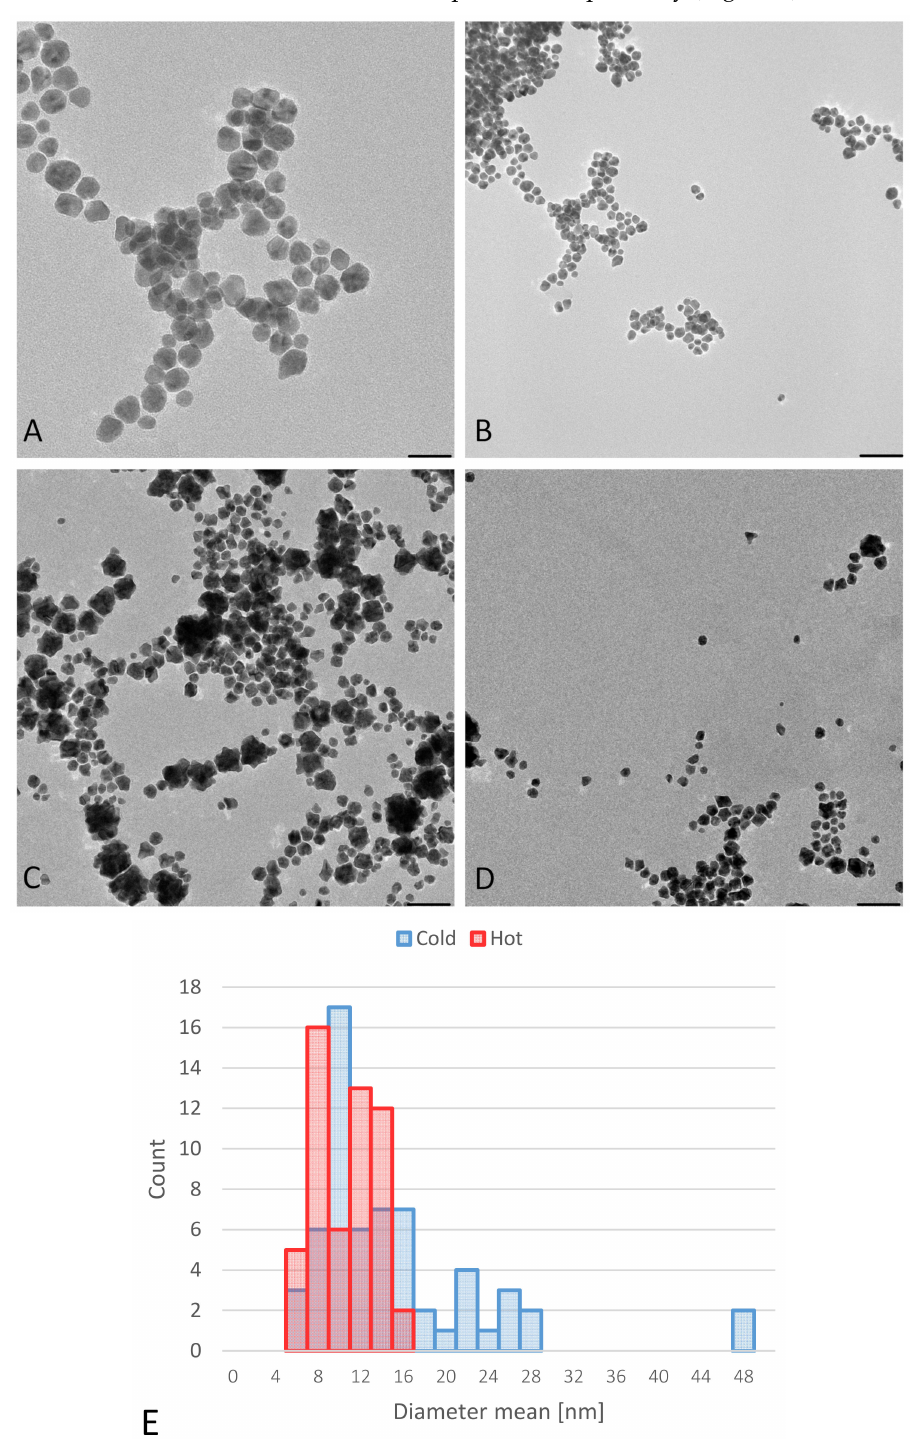
Figure 3. TEM-obtained images of “cold” and “hot” AuNP samples. ( A , B ): obtained images from the “hot” sample. ( C , D ): obtained images from the “cold” sample. (Scale bars for B – D = 50 nm and for A = 20 nm). ( E ): Size distribution histograms of “cold” and “hot” AuNP